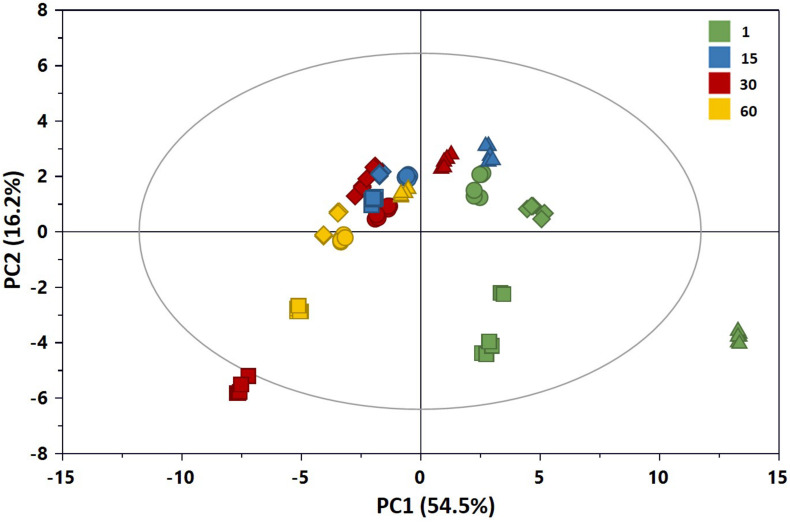
PC1 vs. PC2 scores plot of the PCA model built with the 1H NMR spectra of the aqueous extracts of Caciotta (R2X = 0.707; Q2 = 0.698): CC (•), C1 (▲), C2 (◆), C3 (■). The color of scores denotes the ripening days. The reader is remanded to the color version of the figure.